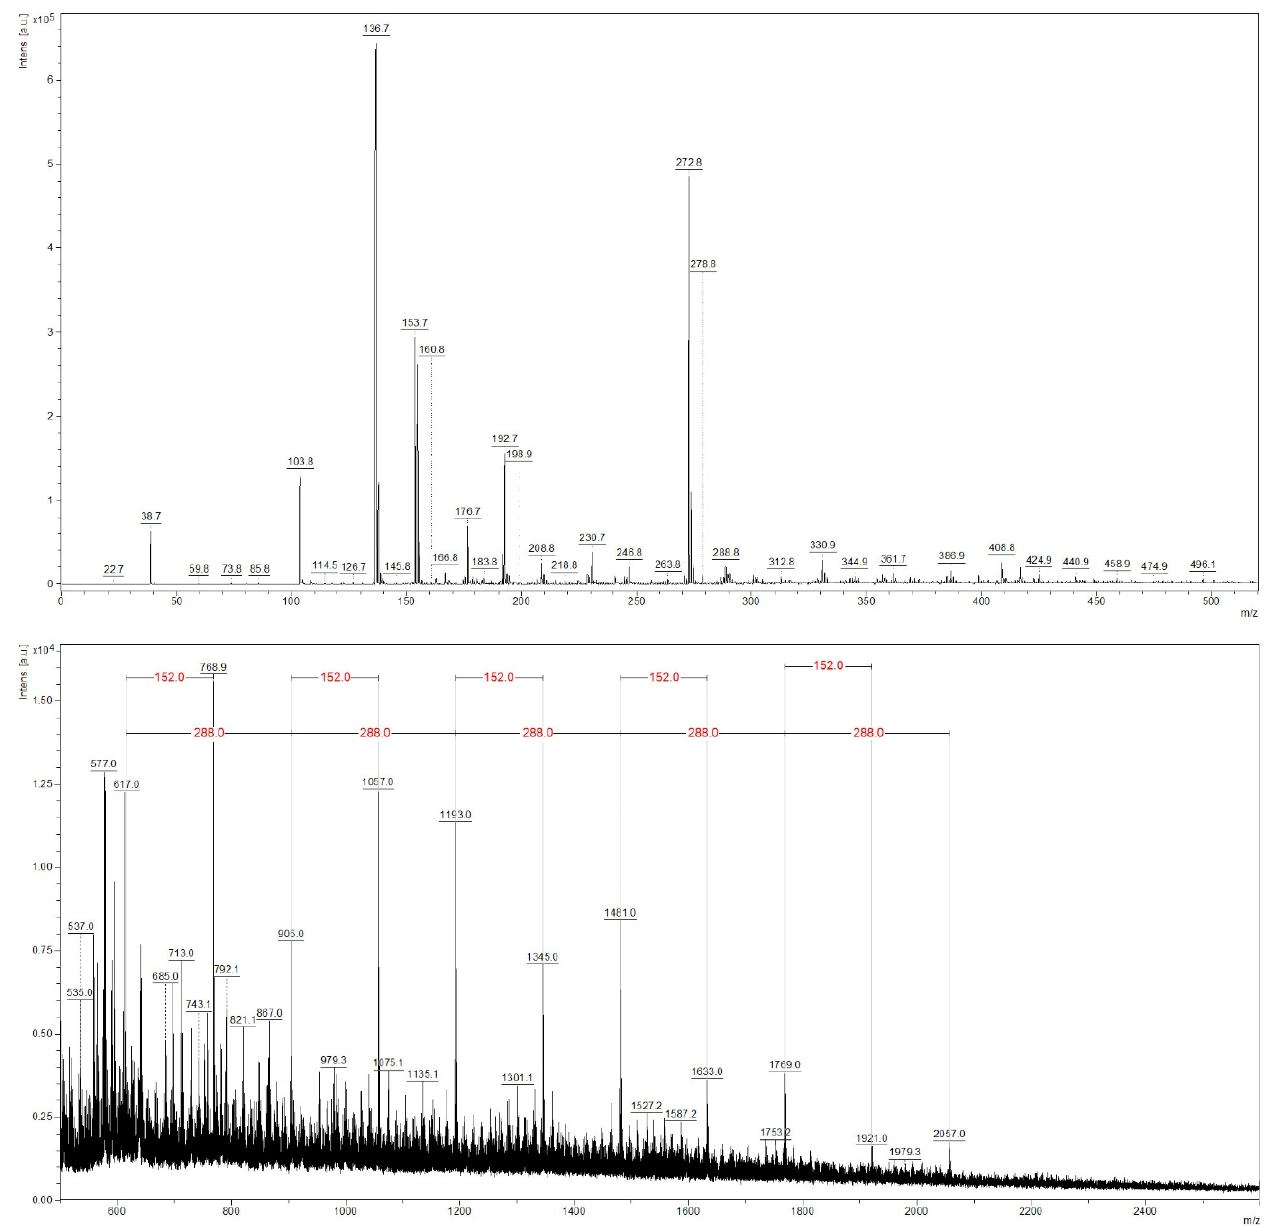
Figure 3. The MALDI-TOF mass spectrum of the beech sapwood extract.